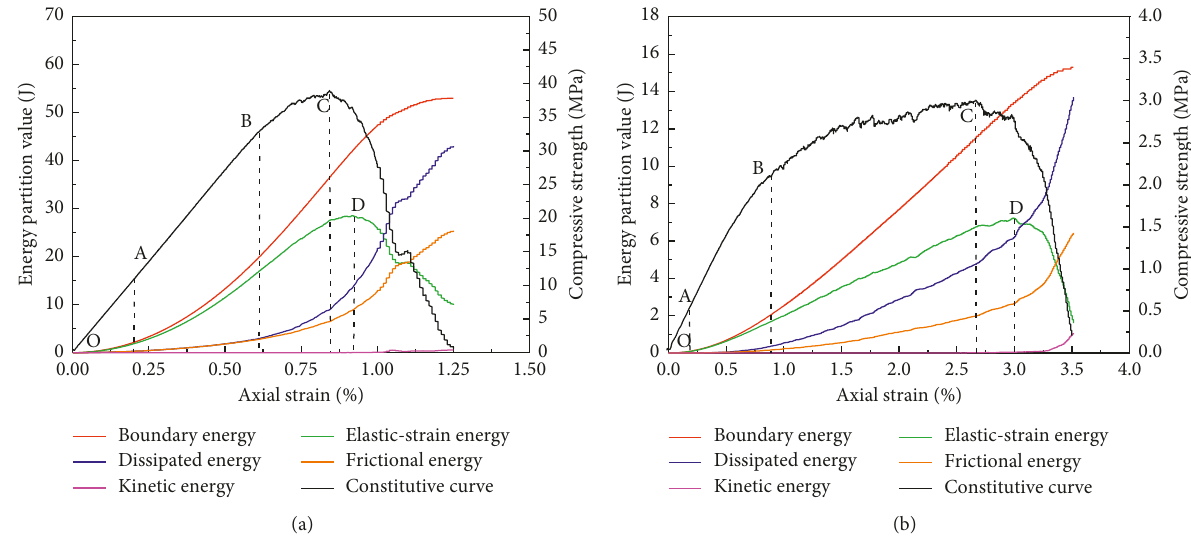
Figure 15: The relationship between the mesoscopic energy evolution law of CRC and their constitutive curves. (a) The rubber mass fraction is 0. (b) The rubber mass fraction is